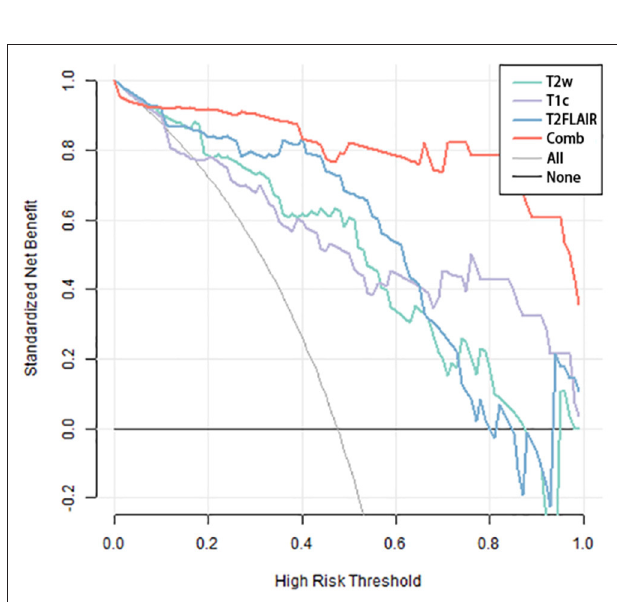
FIGURE 5 | Decision-curve analysis of the four models. The x-axis represents the threshold probability, and the y-axis represents the net benefit. The combined model (red line) had a higher net benefit and better application value for predicting the survival time of patients with midline gliomas.